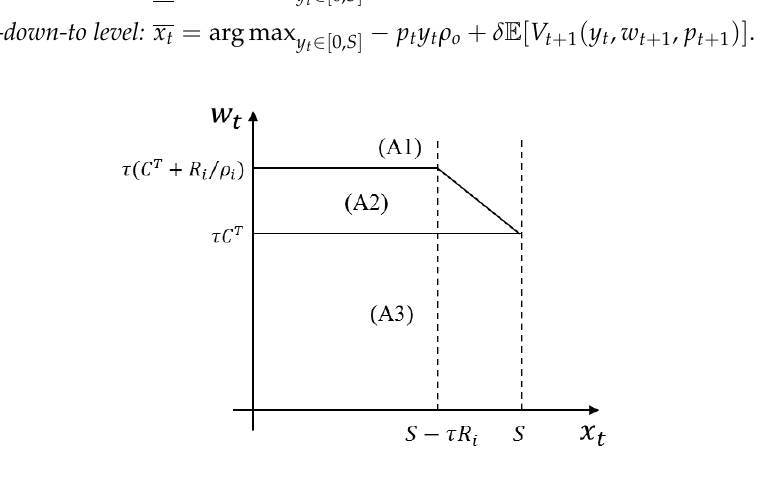
Figure 2. Cases of two state variables x t and w t . Table 2. Situations and corresponding optimal ESS management policies in three